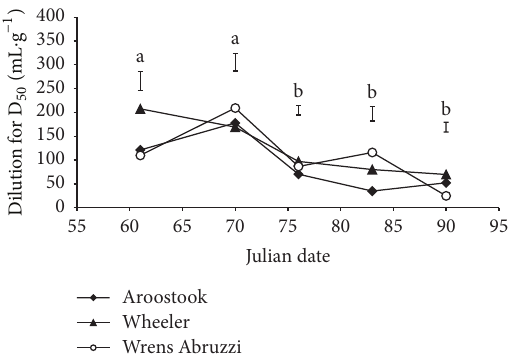
Figure 2: Inhibition of pigweed germination and growth by extracts of three field grown rye varieties, harvested at five different dates (Julian dates) during the spring of the second year of experiments. D 50 is the concentration required to cause 50% growth inhibition. Values associated with the same letter are not significantly different according to the Tukey-Kramer method ( 𝑝 < 0.05 ). Vertical bars represent standard errors at each sampling date.